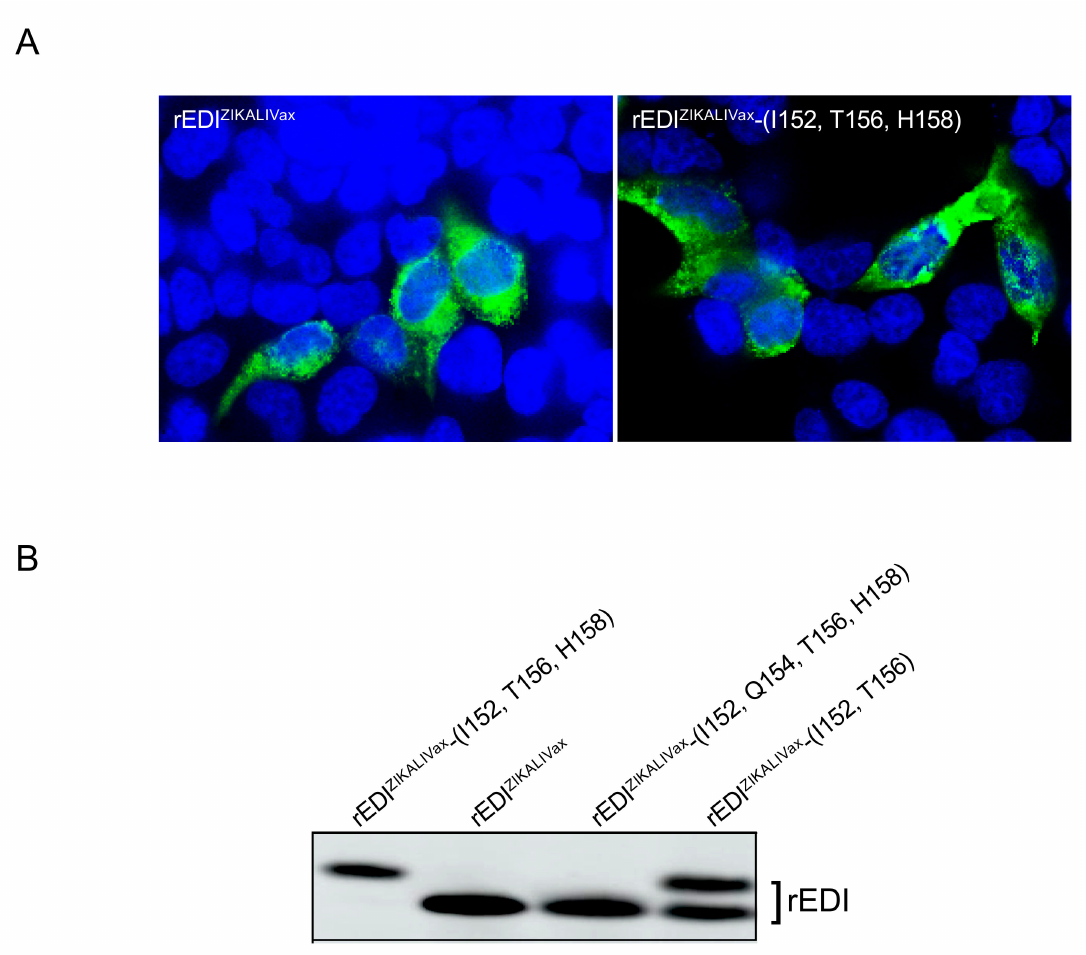
Figure 8. Expression of rEDI ZIKALIVax in HEK-293T cells. HEK-293T cells were transfected 24 h with plasmids pcDNA3 expressing rEDI ZIKALIVax or its mutants. In ( A ), IF assay was performed on fixed and permeabilized cells with anti-6x(His) monoclonal antibody (mAb) as primary antibody. Alexa 488-conjugated anti-mouse IgG antibody as secondary antibody. The nuclei were stained with DAPI (blue). Immunostained cells were visualized with a fluorescent microscope. The same magnification of × 100 was used throughout. In ( B ), immunoblot was performed on RIPA lysates obtained from transfected cells expressing rEDI ZIKALIVax or its mutants using anti-FLAG antibody. FACS analysis was performed to evaluate the reactivity of KLH-peptGL ZIKALIVax immune serum S1-RE with rEDI ZIKALIVax and its three mutants expressed in HEK-293T cells (Figure 9). Anti-FLAG antibody showed that their expression levels were similar at 24 h post-transfection (Figure 9A). As shown in Figure 9B, KLH-peptGL ZIKALIVax immune serum S1-RE has ability to react with rEDI ZIKALIVax expressed in HEK-293T cells. The mean fluorescence intensity (MFI) values of GL peptide-reactive antibody and anti-FLAG antibody were similar, indicating a high level of rEDI ZIKALIVax antigenic reactivity in relation with GL peptide-reactive antibodies. Introduction of amino-acid substitutions E-T152I, E-I156T, and E-Y158H reduced by at least 70% the antigenic reactivity of rEDI ZIKALIVax (Figure9B).Analysis ofmutant rEDI ZIKALIVax -(I152, T156)revealedthat thetwoamino-acid substitutions E-T152I and E-I156T decreased recognition of rEDI ZIKALIVax . Given that amino-acid change E-I156T generates a potential sequon Asn-Asp-Thr into GL region of rEDI ZIKALIVax (Figure S2), the amino-acid substitution N154Q was introduced in glycosylated mutant rEDI ZIKALIVax -(I152, T156, H158) (Figure 9B). The loss of the N-glycosylation site showed no e ff ect on immunoreactivity of mutant rEDI ZIKALIVax . Thus, it seems unlikely that the glycan linked to N154 may play a role in the weaker reactivity of